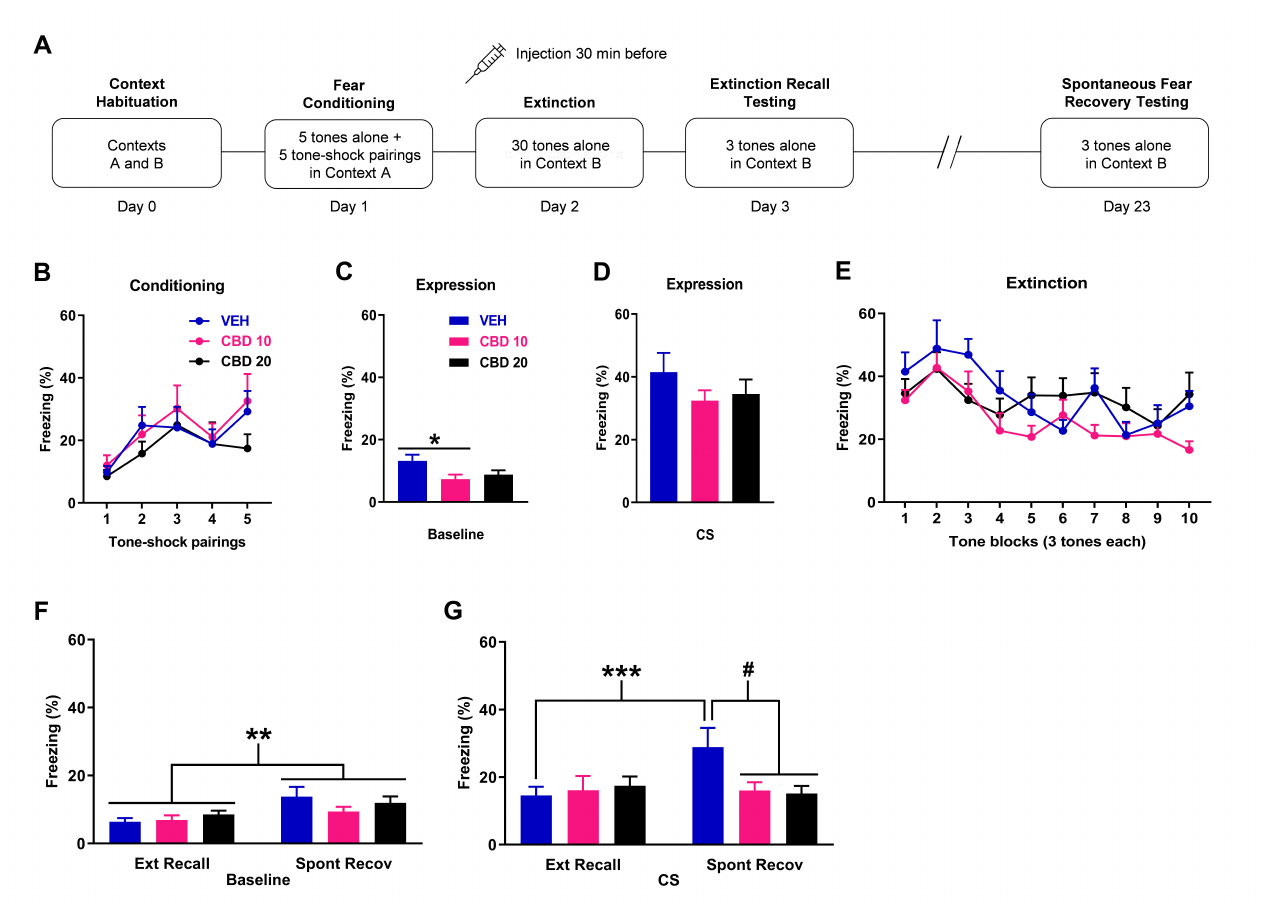
Figure 1. Effects of cannabidiol (CBD) given at 10 mg/kg (CBD 10) or 20 mg/kg (CBD 20) on freezing during delayed extinction, extinction recall testing, and later spontaneous fear recovery